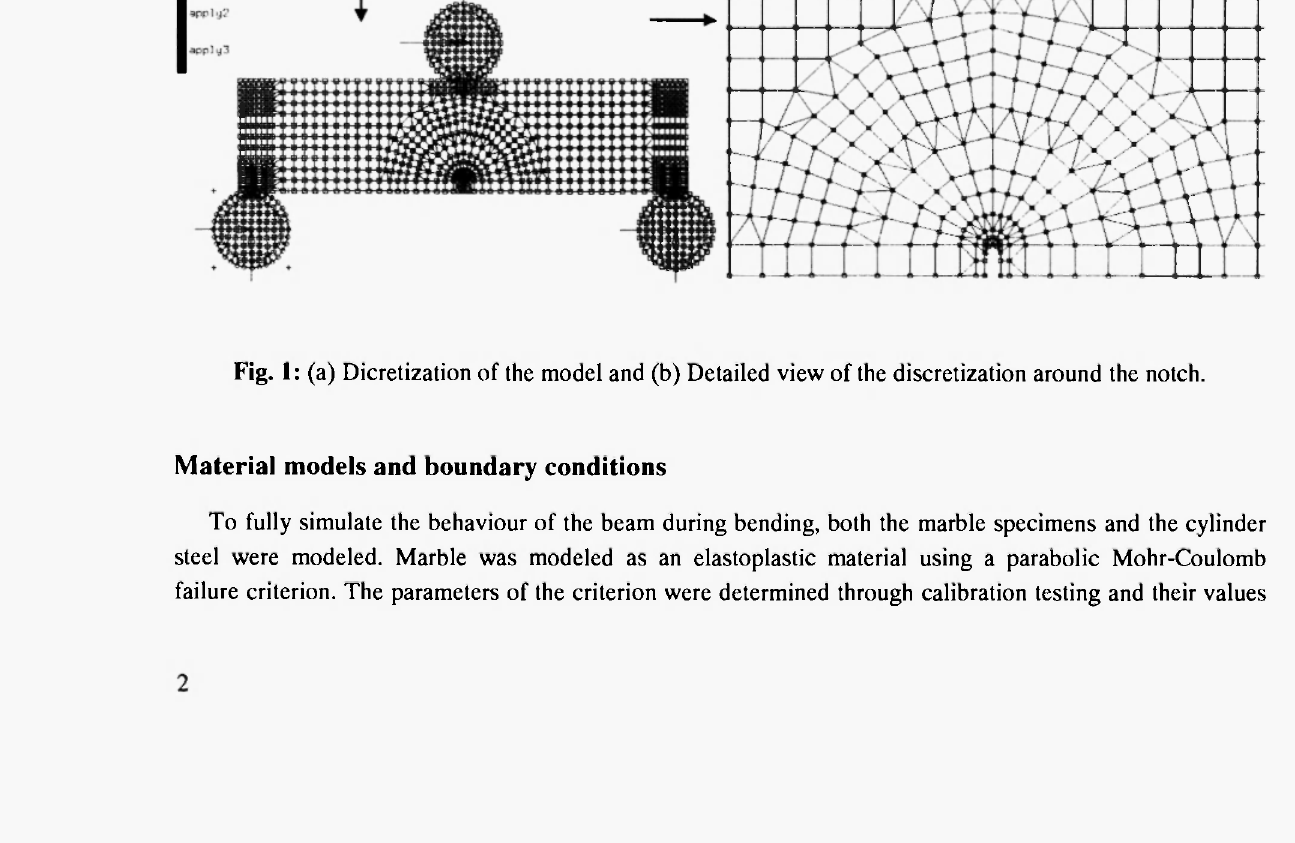
Fig. 1: (a) Dicretization of the model and (b) Detailed view of the discretization around the notch.